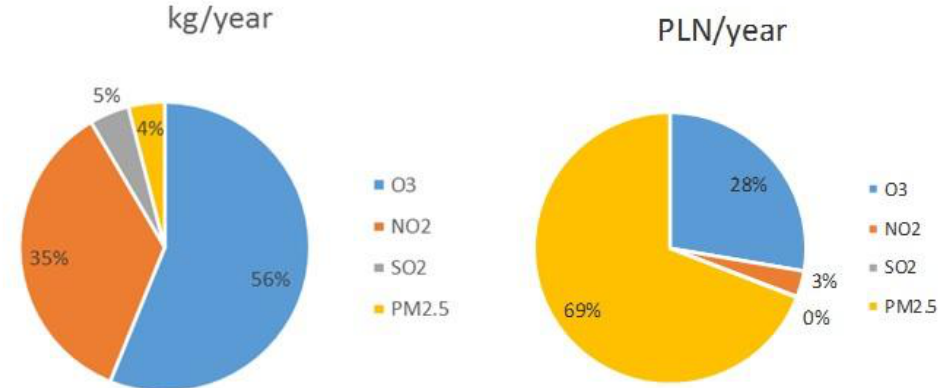
Fig. 5. Annual air pollution removal by air pollutant in kg/year (left) and PLN/year (right) (source: author’s own elaboration based on the results of the i-Tree Eco model and Nowak, 2014) Table 2. Annual air pollution removal by air pollutant in KG/year (left) and PLN/year (right)